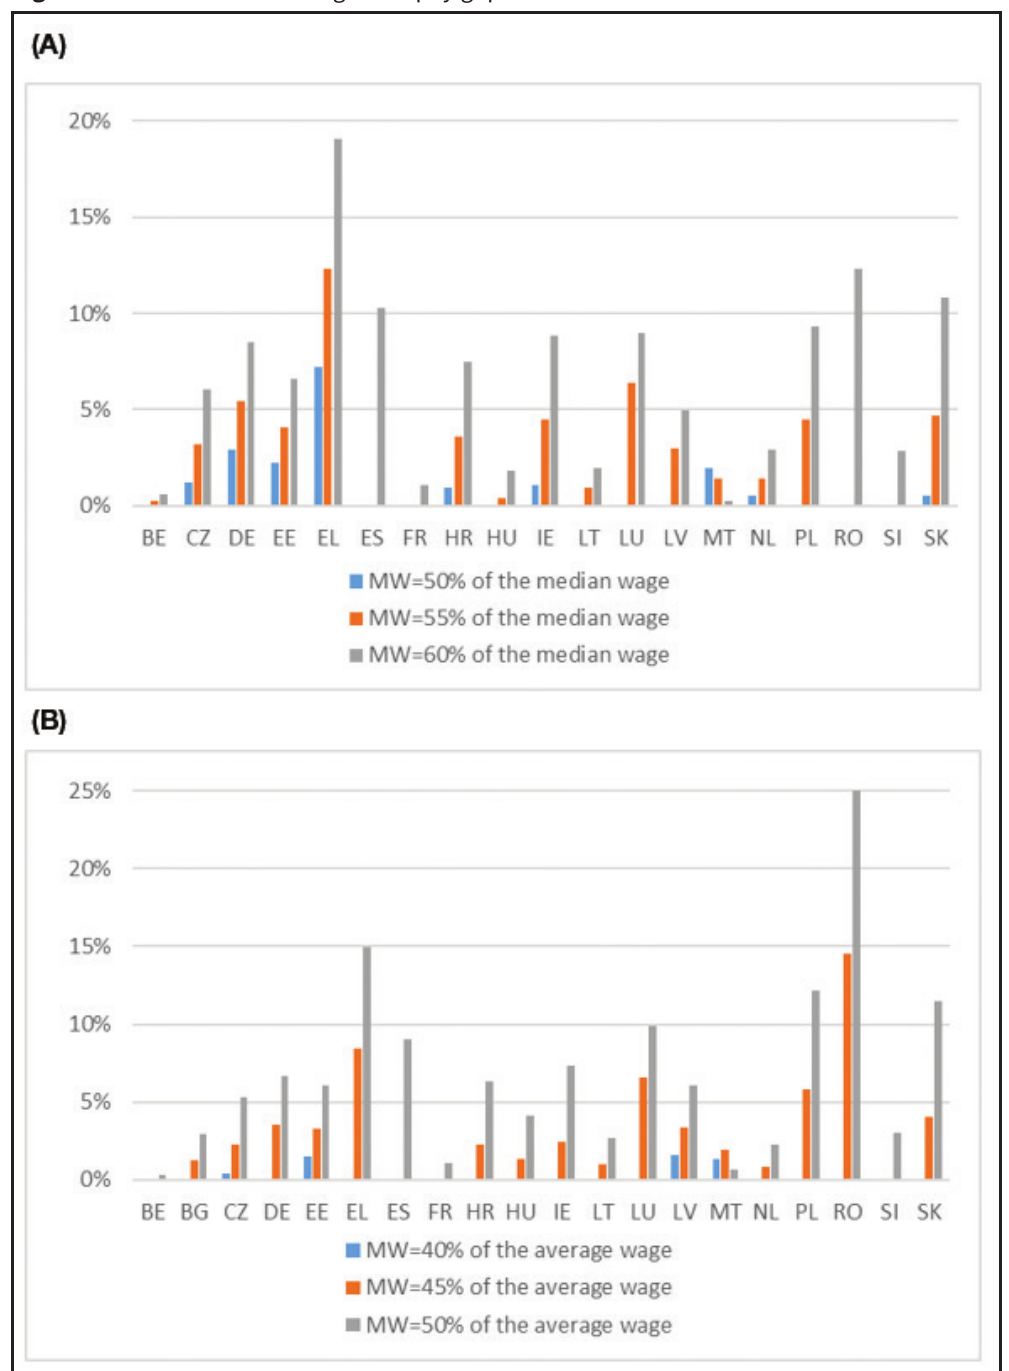
Figure A9 Reduction in the gender pay gap in simulated HMW